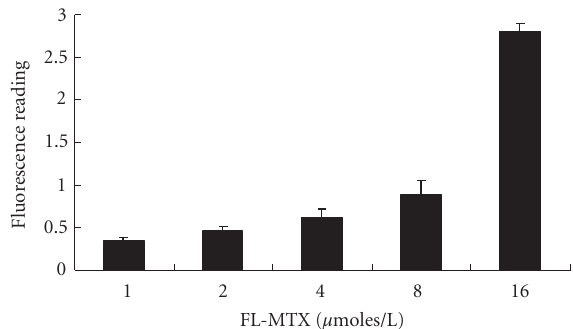
Figure 2: Fluoroskan studies of FL-MTX (10 μ M) uptake by HPT cells in 24 well plates. FL-MTX uptake is directly proportional to its concentrations. Data are expressed as mean ± SEM ( n =